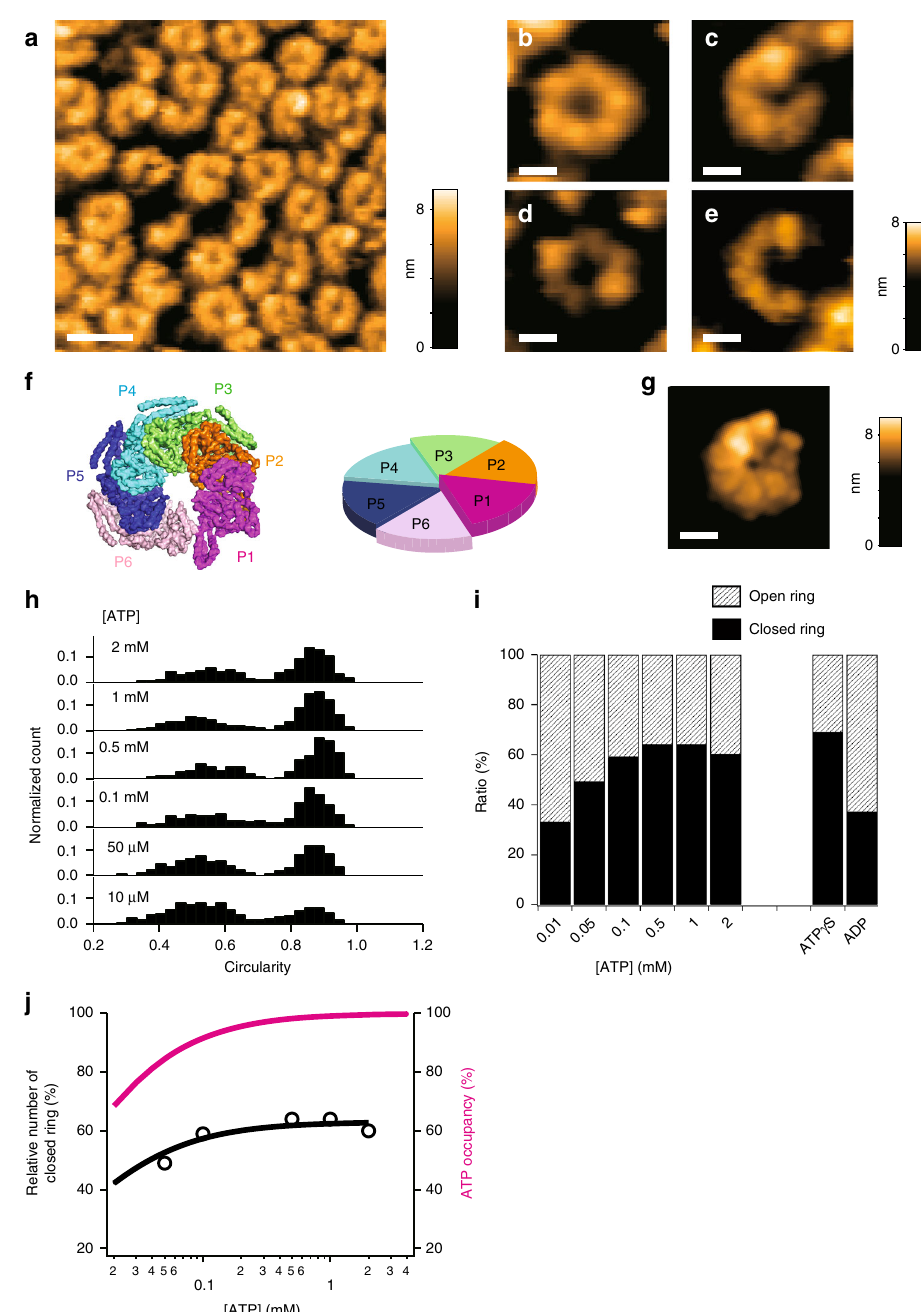
Fig. 1 Diverse oligomeric forms of Δ N- T ClpB observed by HS-AFM. a HS-AFM image acquired in 0.5 mM ATP at 25 °C. Scale bar, 20 nm. Z color bar, 0 to 9.2 nm. b – e Four typical oligomeric forms observed in the presence of ATP: b round closed ring, c spiral, d twisted-half-spiral, and e open ring. We collectively refer to the spiral and twisted-half-spiral rings as the distorted closed ring. Scale bar, 5 nm. Z color bar, 0 to 8.0 nm. f Cryo-EM structure of spiral hexamer of Hsp104 without N-terminal domains (PDB code: 5KNE) 39 and schematic of the spiral architecture. g Simulated AFM image of N- terminal-truncated spiral hexamer of Hsp104 constructed using a cone-shaped probe with a tip radius of 0.5 nm and a half cone angle of 5°. The constructed image was fi ltered by a low-pass fi lter with a cut-off frequency of 3 nm. Scale bar, 5 nm. Z color bar, 0 to 9.3 nm. h Histograms of circularity for the oligomers formed at different [ATP]. Numbers of molecules analyzed are 425 (10 μ M), 389 (50 μ M), 438 (0.1 mM), 415 (0.5 mM), 624 (1 mM), and 410 (2 mM). i Percentages of closed (black area) and open (hatched area) forms at various [ATP] estimated from the histograms. A threshold value of circularity was set at 0.68. Percentages of the closed and open forms observed at 1 mM ATP γ S and 1 mM ADP are also displayed (413 molecules for ATP γ S and 432 molecules for ADP). j Percentage of closed rings as a function of [ATP] (open circles). The data points were fi tted by a simple 1:1 binding model with an apparent K d = 9.9 ± 1.8 μ M (mean± s.d.) (black line). The magenta line shows ATP occupancy in the ATP-binding sites of Δ N- T ClpB hexamers theoretically calculated using an apparent K d (9.2 μ M) estimated by replacement titration of bound mant-ADP with ATP (Supplementary Figure